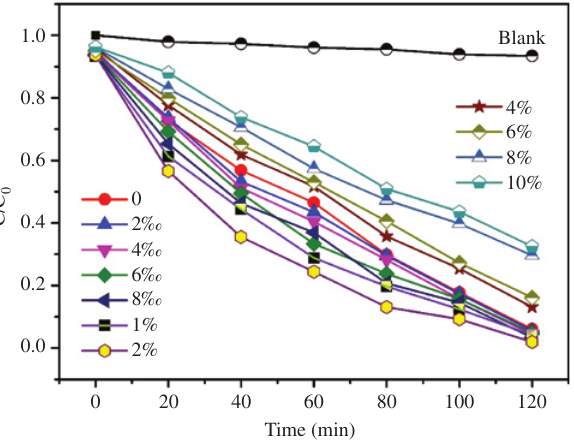
Figure 9: Photocatalytic degradation of RhB under visible light ( λ > 400 nm) illumination as a function of irradiation time for the as- prepared rGO-BWO samples with different R M